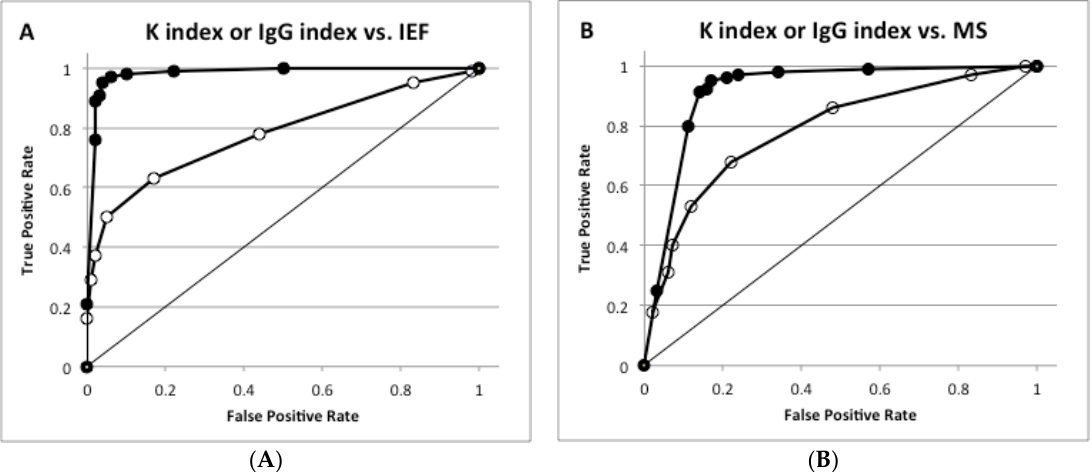
Figure 2. Receiver operating characteristic (ROC) analysis for K and IgG indexes in predicting OB detection and diagnosing multiple sclerosis. ( A ) K index or IgG index vs. isoelectric focusing (IEF); ( B ) K index or IgG index vs. MS.